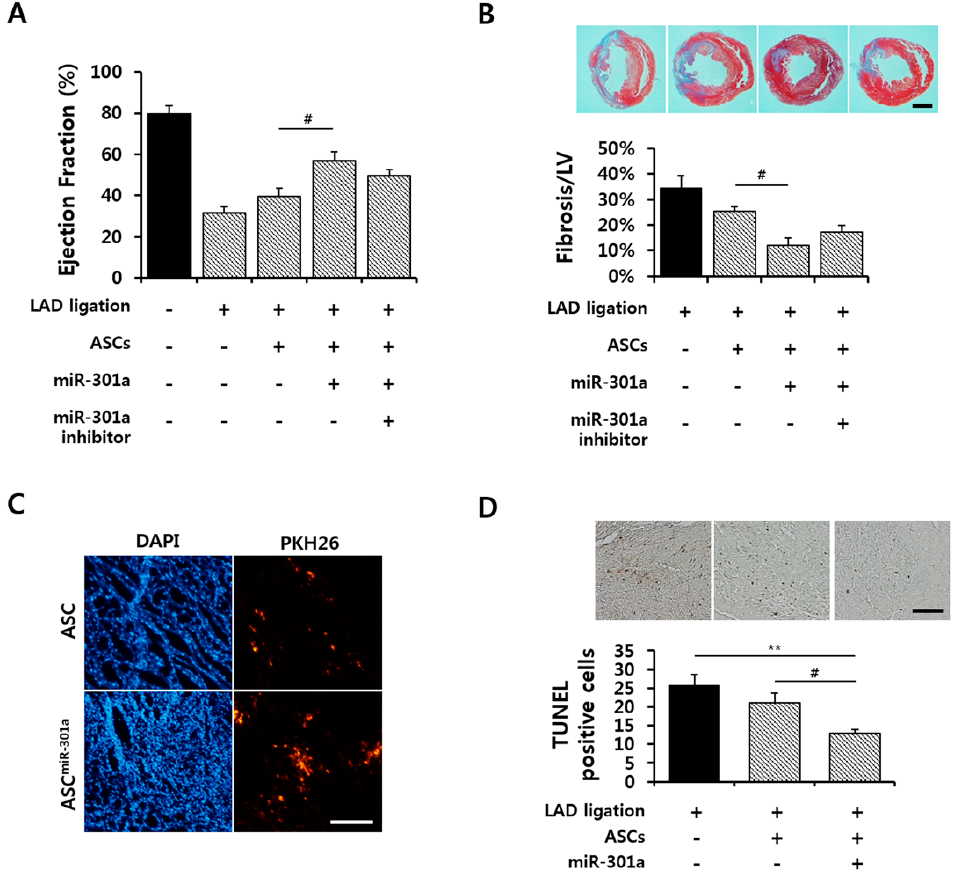
Figure 5. Effects of hASC miR-301 on cardiac function after myocardial infarction (MI). ( A ) Cardiac functions were assessed using a Millar micro-tip 2 F pressure transducer at one week after MI ( # p < 0.05); ( B ) Fibrosis was detected by Masson’s trichrome staining from three rats per group. Scale bar = 5 mm ( # p < 0.05); ( C ) One week after the ASCs injection, PKH26-stained ASCs were detected in the ischemic myocardium. Scale bar = 200 μ m; ( D ) Representative histological sections of ischemic myocardium stained with TUNEL assay at one week after MI. Quantitative analysis was performed for TUNEL (terminal deoxynucleotidyltransferase-mediated dUTP nick-end labeling) positive cells. Scale bar = 100 μ m ( ** p < 0.01, # p < 0.05).